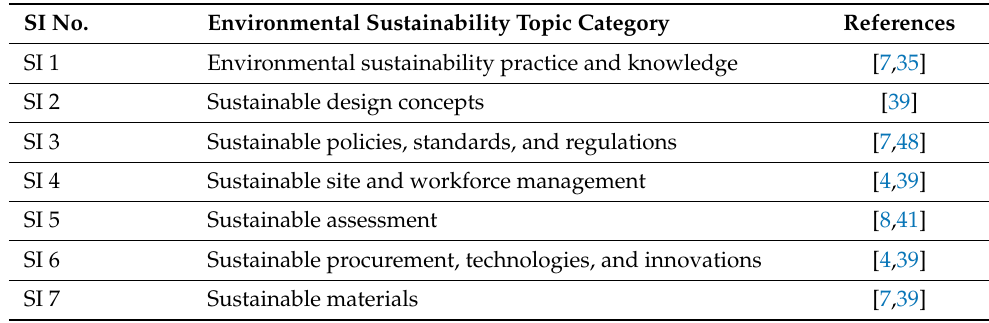
Table 2. Key environmental sustainability education categories. SI